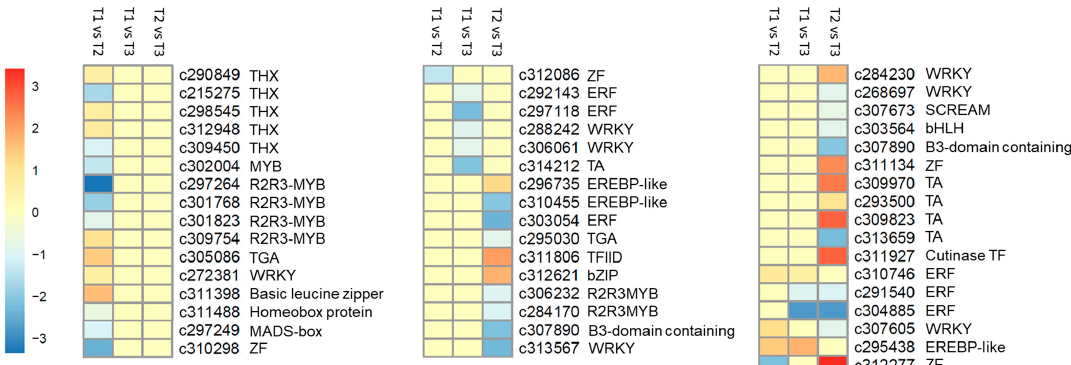
Figure 4. Heatmap representing log2 FC of differentially expressed transcription factors in masson pine roots treated with different N-sources. Transcript IDs are followed by the transcription factor class. TA = the transcripts that showed transcription activity but were not annotated in any database.